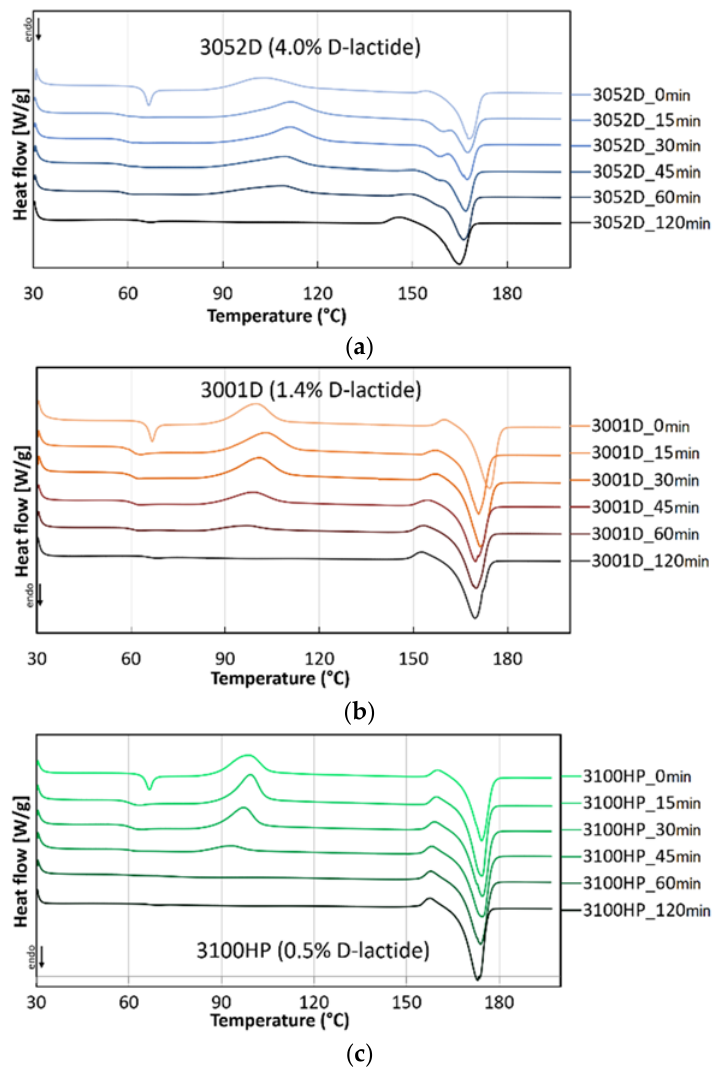
Figure 5. Thermograms of 3052D ( a ), 3001D ( b ) and 3100HP ( c ) type PLA annealed for 0–120 min.